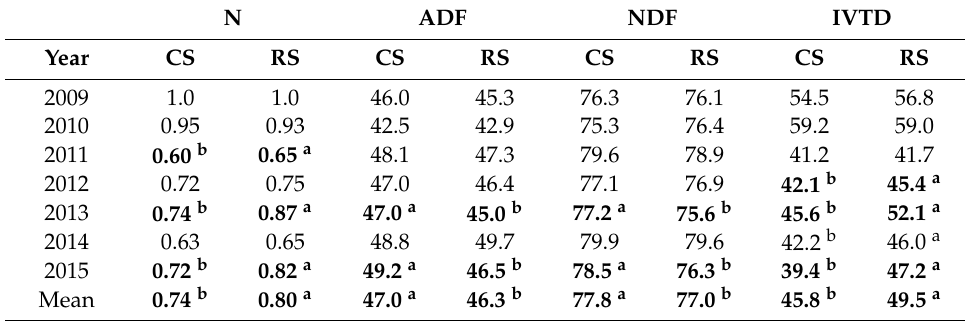
Table 4. Comparison of treatment (CS = continuous stocking, RS = rotational stocking) means of concentrations (% of dry matter) of total nitrogen (N), acid detergent fiber (ADF), neutral detergent fiber (NDF), and in vitro true digestibility (IVTD) by year of study.